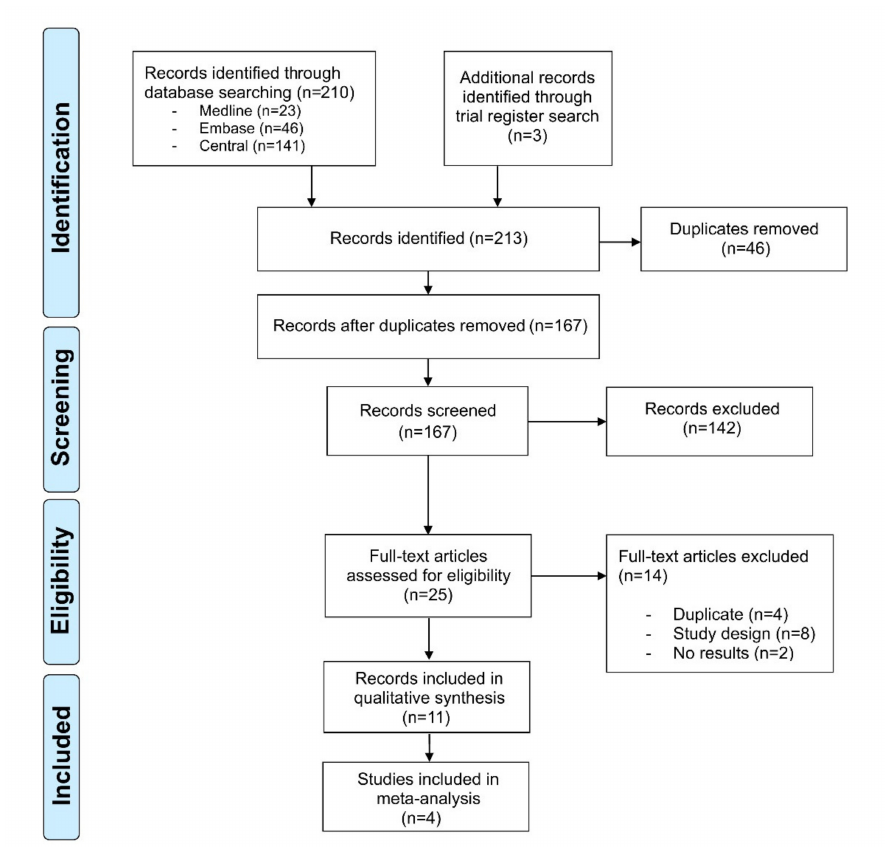
Figure 1. PRISMA flowchart of the study. Selection process for study inclusion in the systematic review and meta-analysis according to the Preferred Reporting Items for Systematic Reviews and Meta-Analysis